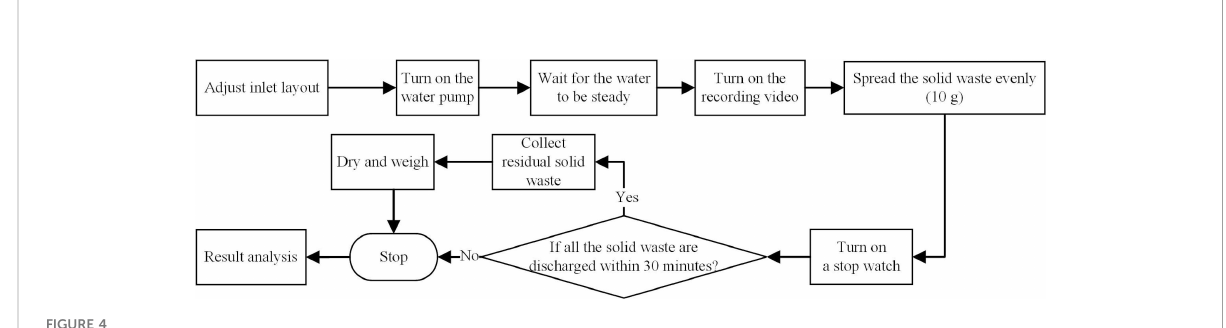
FIGURE 4 Flowchart of solid waste removal